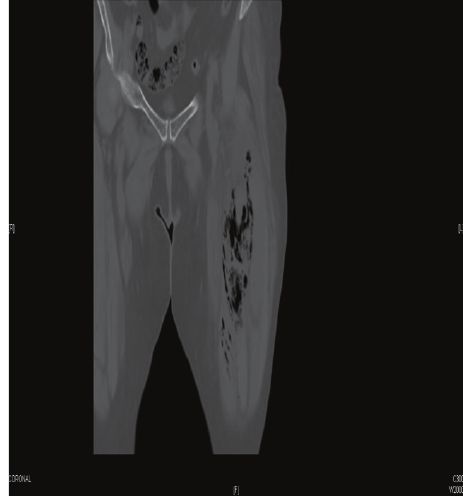
Figure 2: TC: edema and air on fascia between rectus femoris and vastus